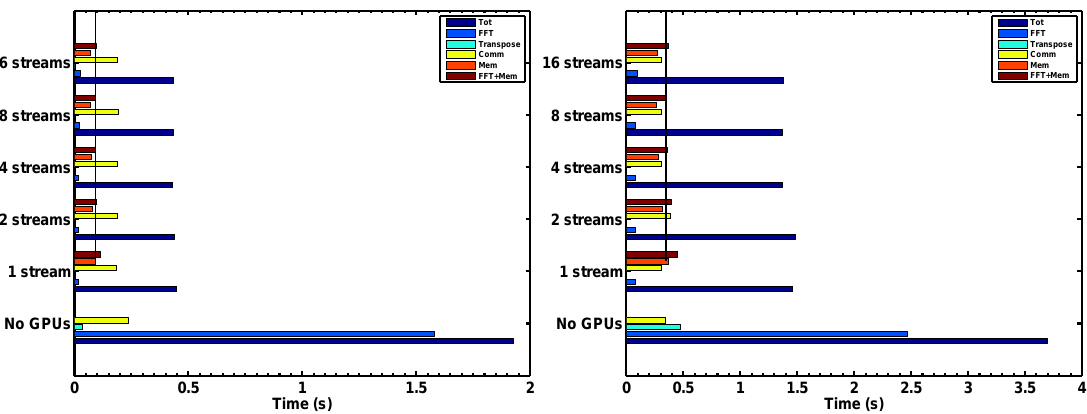
Figure 3. Total time (Tot) and operation times for GPU runs (time to compute FFTs, transpose, MPI communication, memory copy from and to the GPU, and FFTs plus copies) with varying number of CUDA streams. ( Left ) On the NVLink system and ( right ) on the PCIe system (see Table 2). The minimum transfer time in both cases is seen for nstreams = 8, and its time t indicated by the dark vertical line (compare the increase in this time for nstreams = 1). In the bottom of each figure, the total and component times (excluding device transfer time) are provided for a corresponding CPU-only run using the same number of MPI tasks and threads per